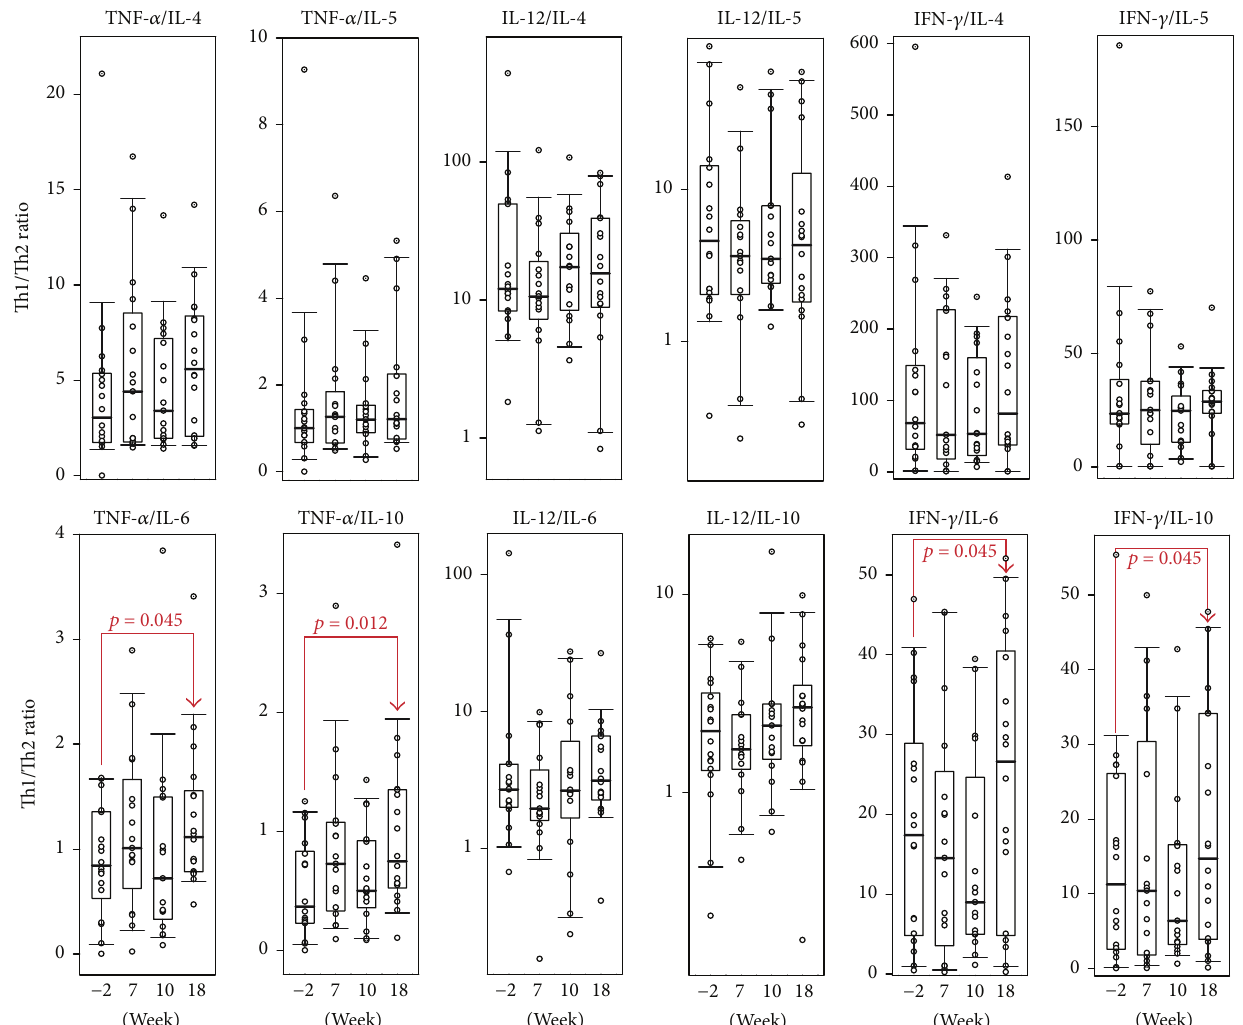
Figure 2: The Th1/Th2 serum ratio in the treatment group at the time of the screening ( − 2 weeks), 7, 10, and 18 weeks. The interquartile range is shown by boxes. The median in each group is shown by the bold line. Bars represent 95% confidence interval. Statistically significant differences with their respective 𝑝 values are